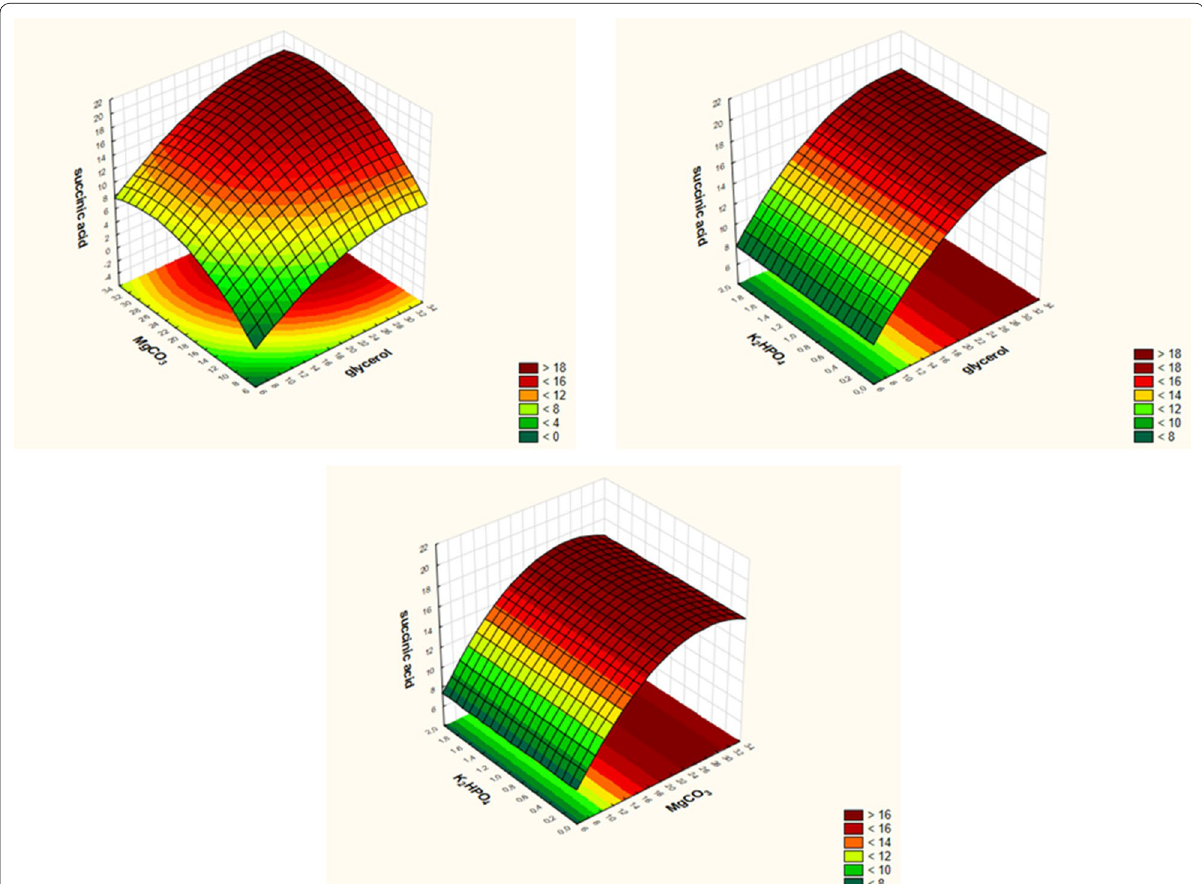
Fig. 2 Response surface plots showing the effects of (x 1 ) crude glycerol, (x 2 ) magnesium carbonate and (x 3 ) dipotassium phosphate on (Y) succinic acid concentration